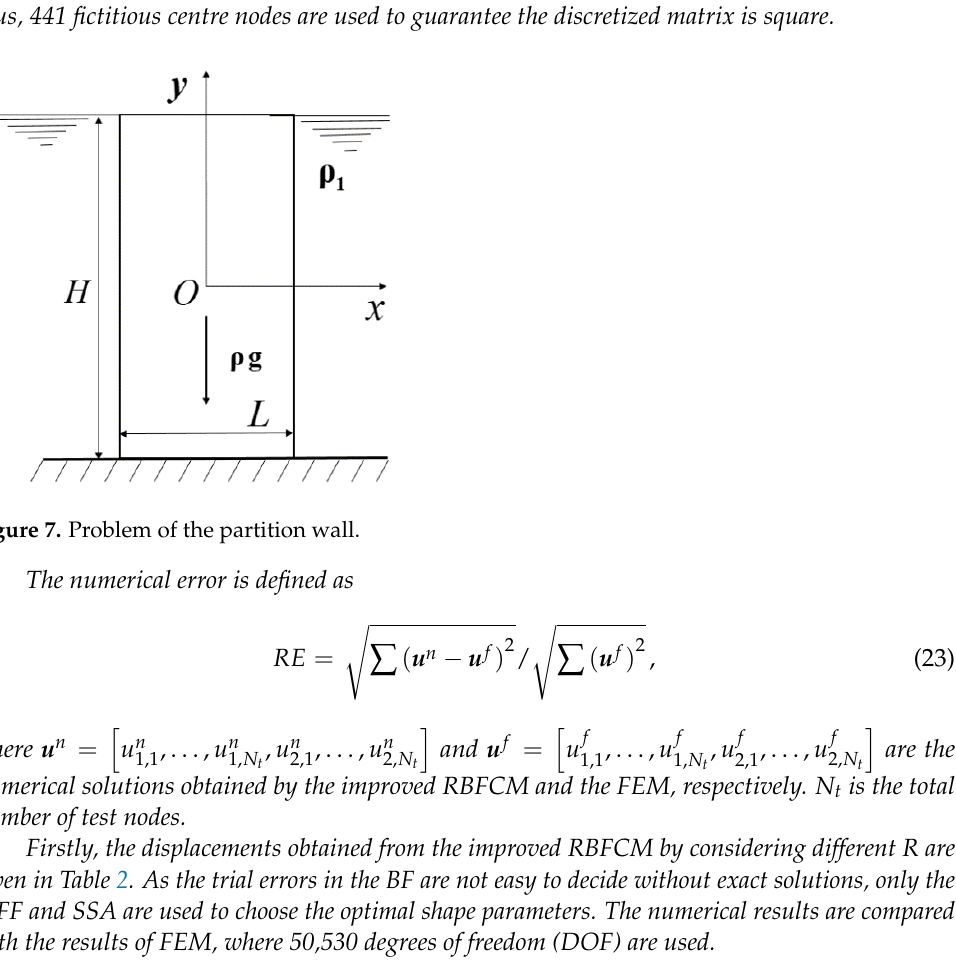
Table 2. Relative errors by comparing with the